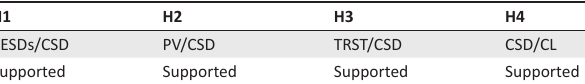
TABLE 6: Summary of